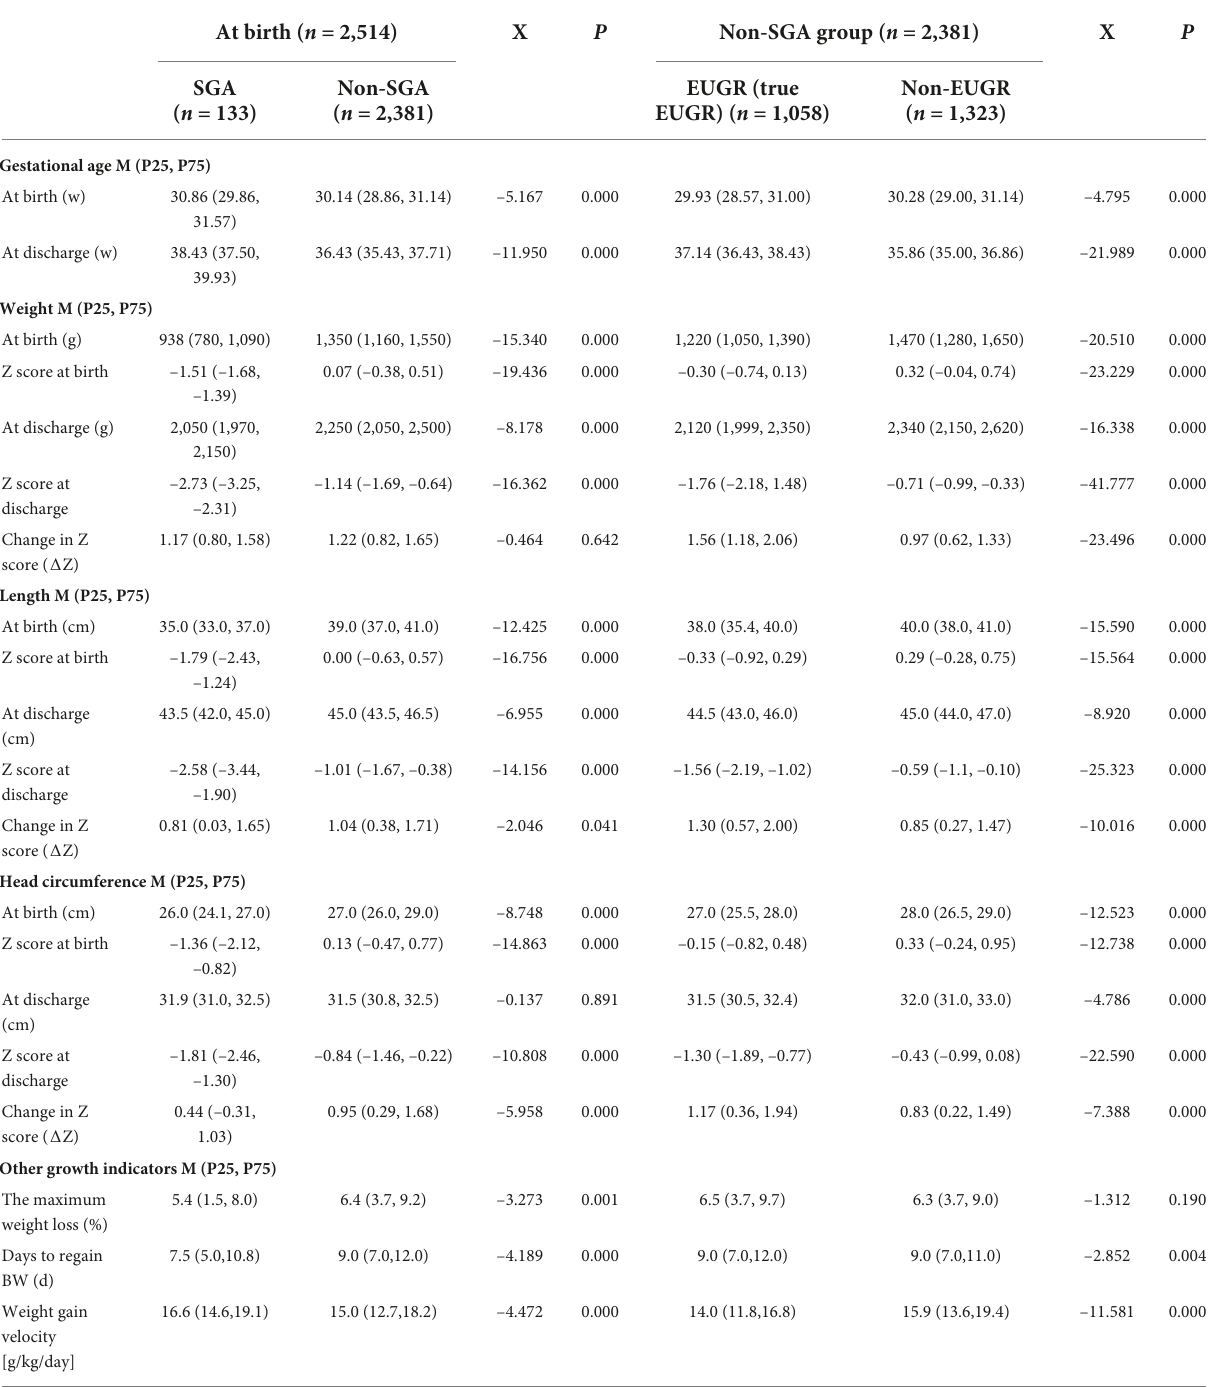
TABLE 2 Comparisons of growth between the